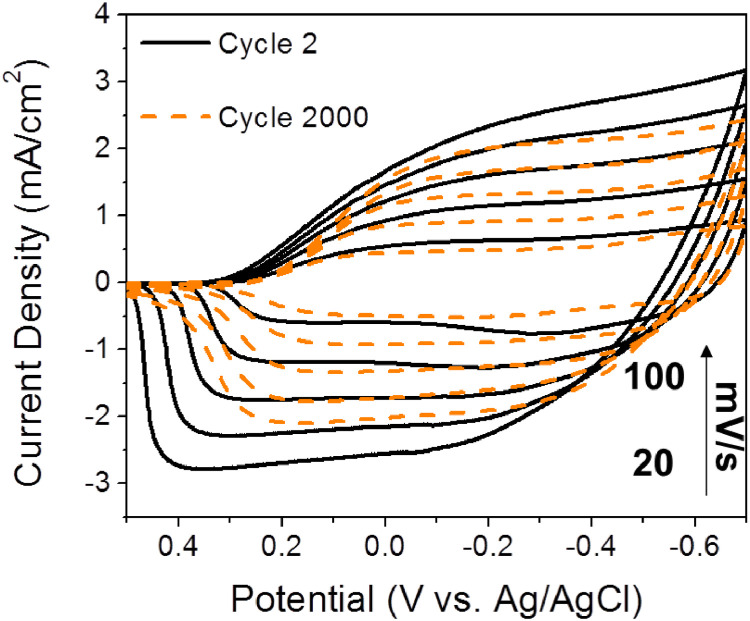
Cyclic voltammograms of WO3 film deposited by TPA method on ITO glass acting as WE in 0.1 M K2SO4 at different scan rates in the potential range of −0.7 to 0.5 V vs Ag/AgCl at 2nd cycle (solid line) and 2000th cycle (dash line).